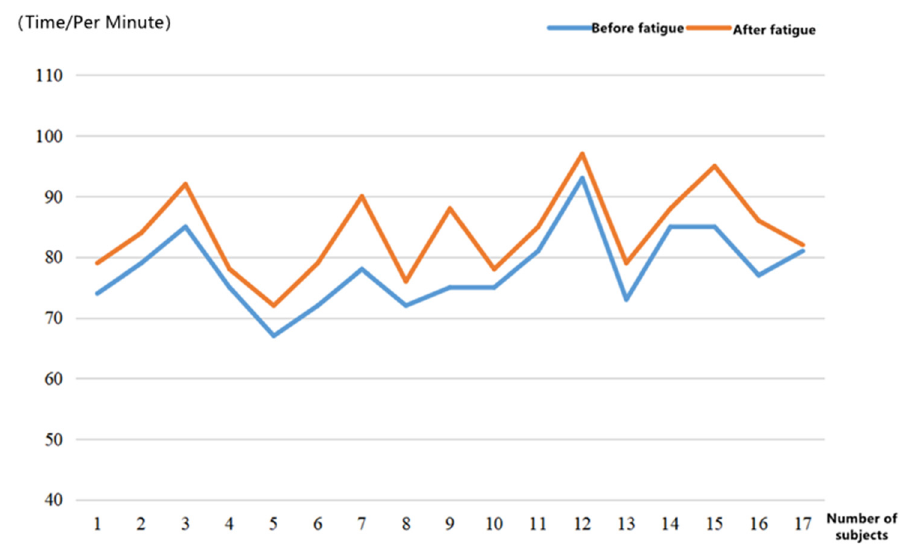
Figure 10. Changes in heart rate. The heart rate data were divided into two groups according to pre- and post brain fatigue, and a paired samples t -test was performed on the two groups using SPSS 26.0. The results of the test are shown in Table 9. Table 9. Paired samples t -test results of heart rate.